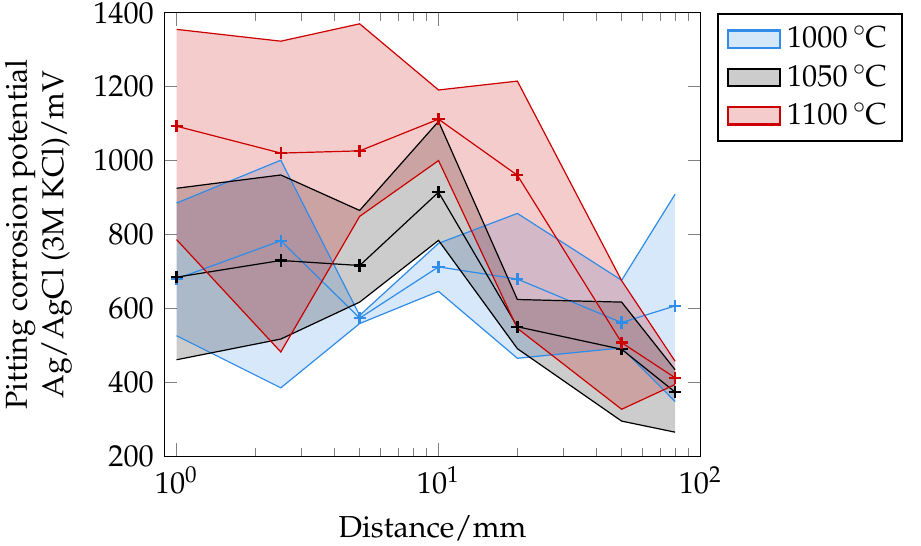
Figure 24. Experimentally determined pitting corrosion potential as a function of the distance from the quenched end face of the Jominy end quench test in mV. (Measuring points indicated by marks (+): 1 mm, 2.5 mm, 5 mm, 10 mm, 20 mm, 50 mm, 80 mm.). Table 9. Pitting corrosion potentials Ag/AgCl (3 mol KCl)/mV